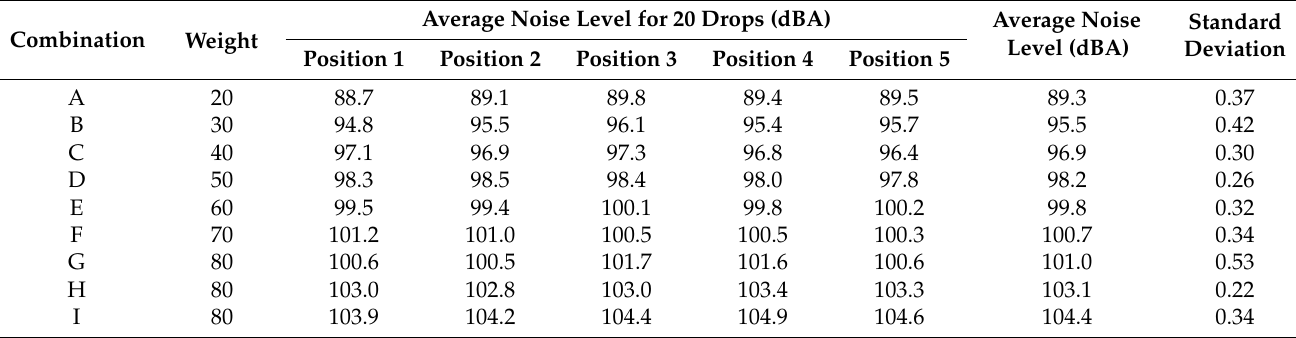
Table A4. Detailed data of four selected groups (squat).